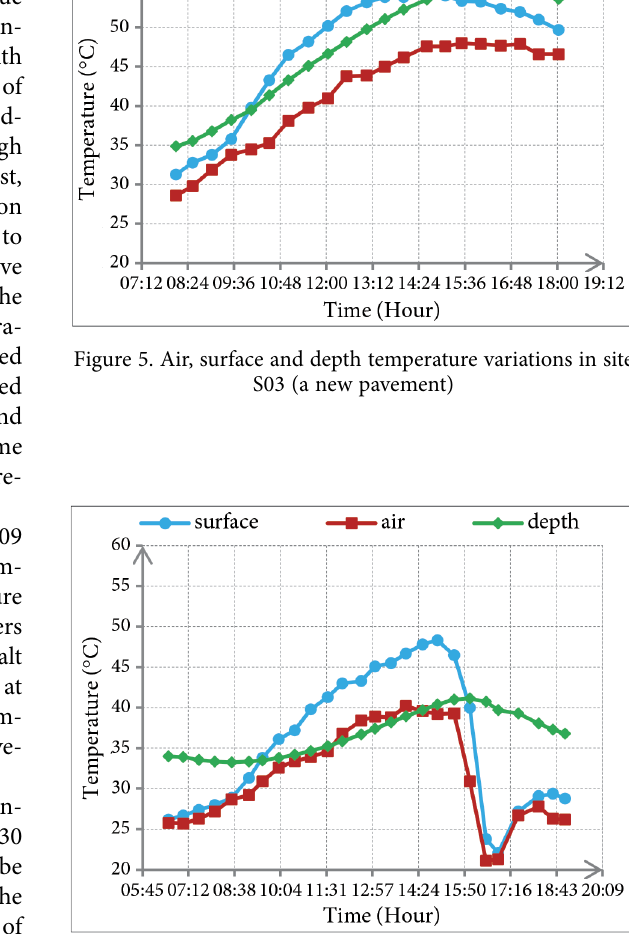
Figure 6. Air, surface and depth temperature variations in site